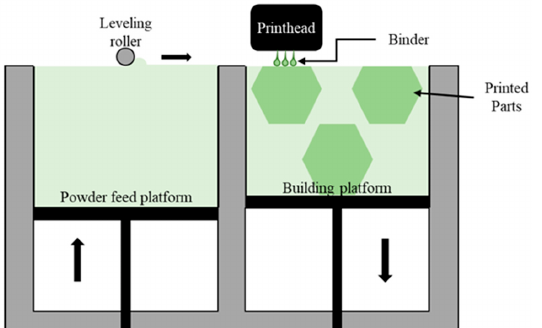
Figure 1. Schematic representation of binder jetting working mechanism additive manufacturing printing process. Reprinted with permission from Ref. [43]. Copyright 2020 by the authors and li- censee MDPI, Basel,